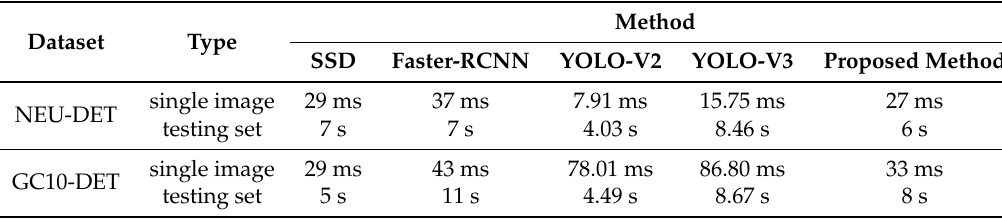
Table 8. Comparison of Computational Time on Two datasets for traditional